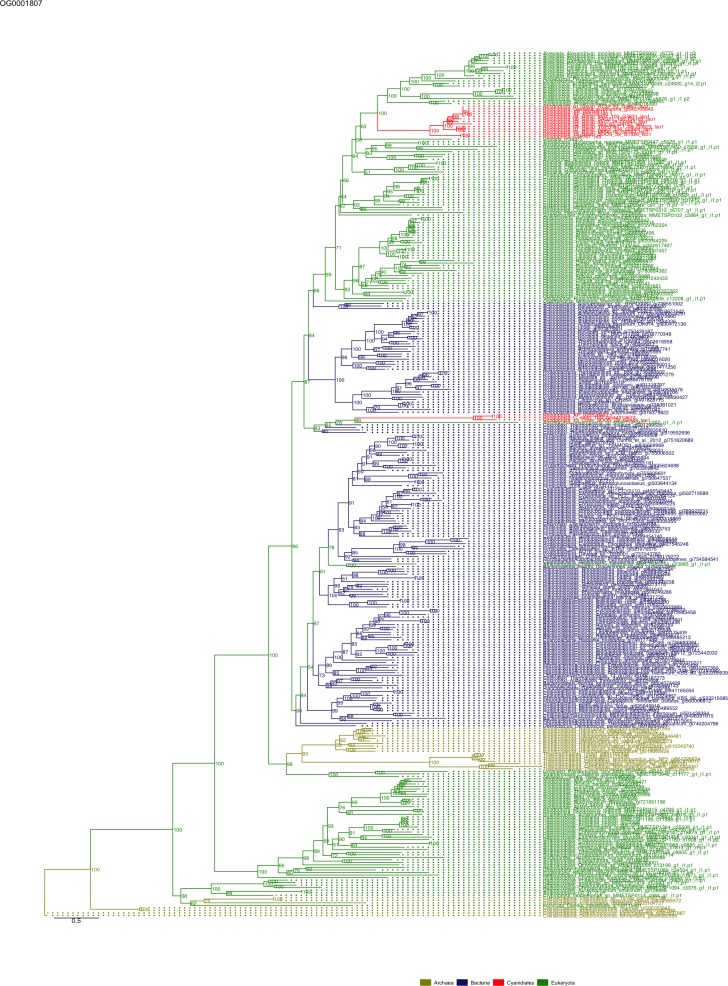
Sequence tree of orthogroup OG0001807.The tree is based on amino acid sequences. Archaea (yellow), Bacteria (blue), Cyanidiales (red), Eukaryotes including other red algae (green). Branches containing Cyanidiales sequences are highlited in red.